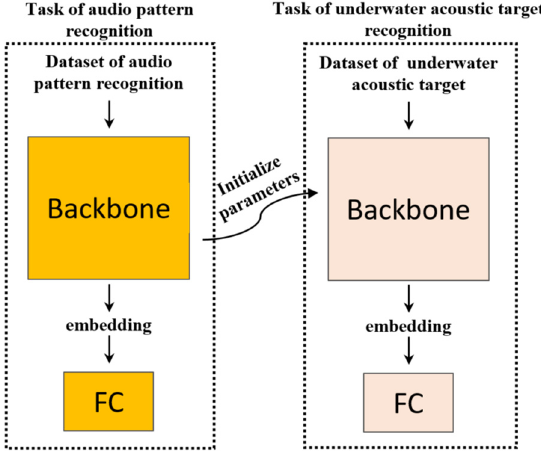
Figure 7. The schematic diagram of model based transfer learning strategy. Table 2. Backbones are used in this